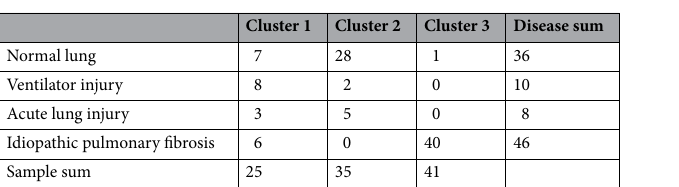
Table 1. Lung sample clusters related to